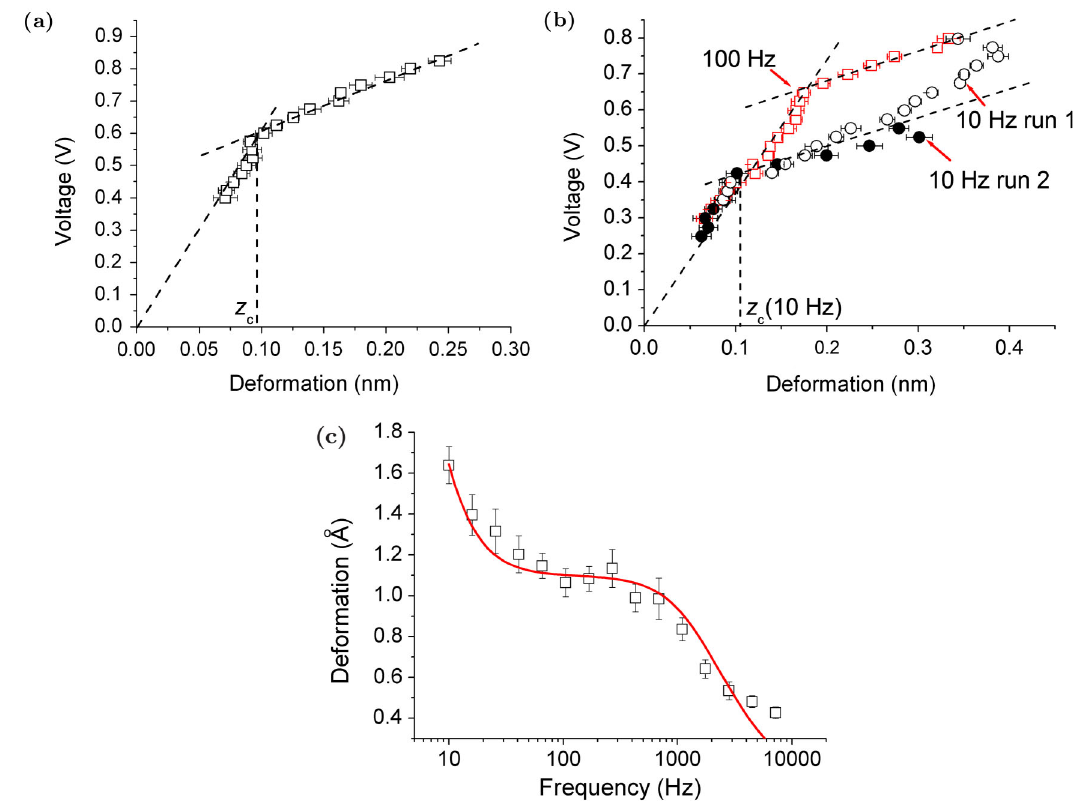
FIG. 2. The (ensemble-averaged) AC-driven mechanical response of GK. The amplitude of the oscillating force applied to the GNPs is proportional to the voltage; the horizontal axis is the measured amplitude of the resulting deformation. (a) The force-deformation (cid:3) 1 (cid:1)A , where z is the deformation of GK. To the curve is piecewise linear, the break in the slope occurring at a ‘‘yield’’ deformation z c left of this transition is the linear-elasticity regime (the straight line extrapolating to the origin), where the protein behaves like a simple spring. To the right of the transition lies a viscoelastic regime where the protein essentially flows like a viscous fluid [11,13]. The transition is reversible. (b) The mechanical response as in (a) measured at two different frequencies (10 Hz, empty and filled circles, and 100 Hz, red squares) for the same sample [which is a different sample from the one in (a)]. These measurements show that the ) is frequency dependent. For the 100 Hz curve, the linear-elasticity regime is extended up to viscoelastic transition (the yield strain z c larger deformations. The 100-Hz and 10-Hz curves coincide in the linear-elasticity region of the 10-Hz curve, confirming that this is indeed a frequency-independent ‘‘simple-spring’’ regime. The three curves were obtained in the sequence 10-Hz run 1, 100 Hz, 10-Hz run 2. Thus, the filled circles show that these measurements explore nonequilibrium but reversible processes. (c) Amplitude of the response vs frequency for GK at fixed force. The line shows a fit to the simplest description of linear viscoelasticity (Maxwell model) [10]. The drop above 1 kHz is due to the hydrodynamic friction on the GNPs. The protein shows the behavior of a spring between 100 Hz and 1 kHz (the plateau) and that of a viscous fluid below 100 Hz (the